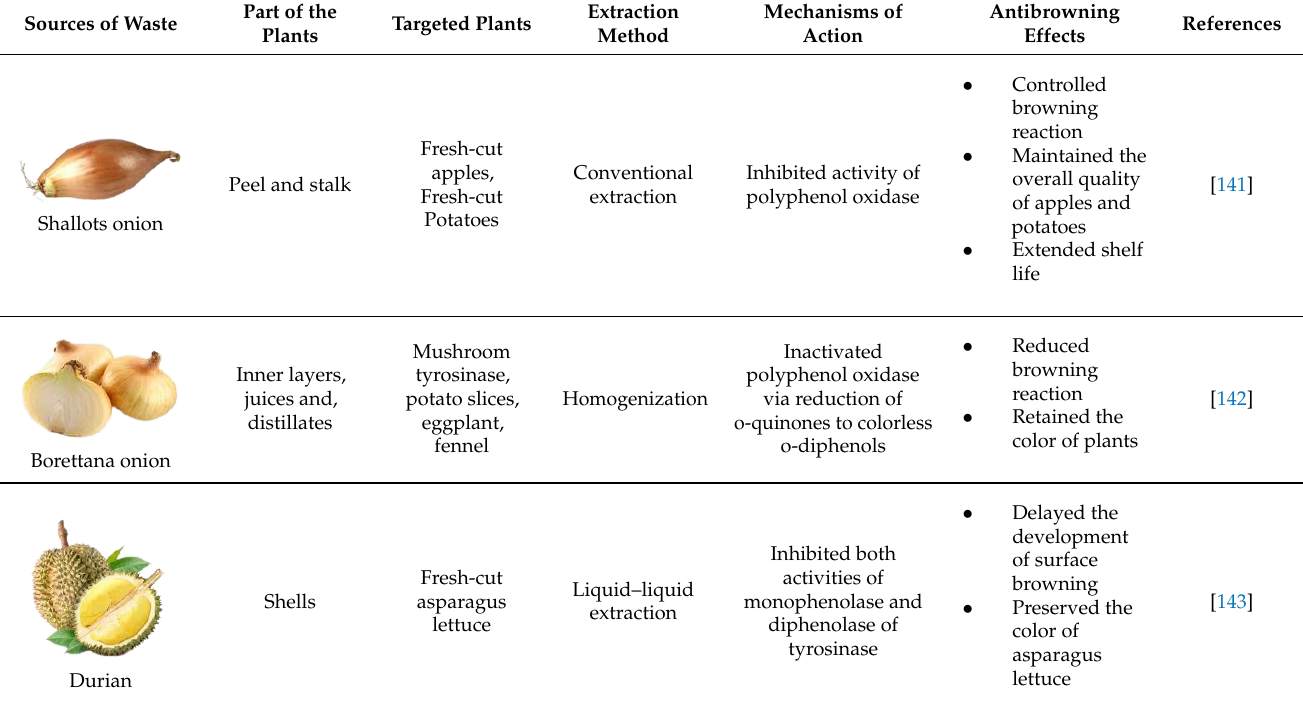
Table 4. Usage of fruits and vegetables waste as antibrowning agents in food applications.